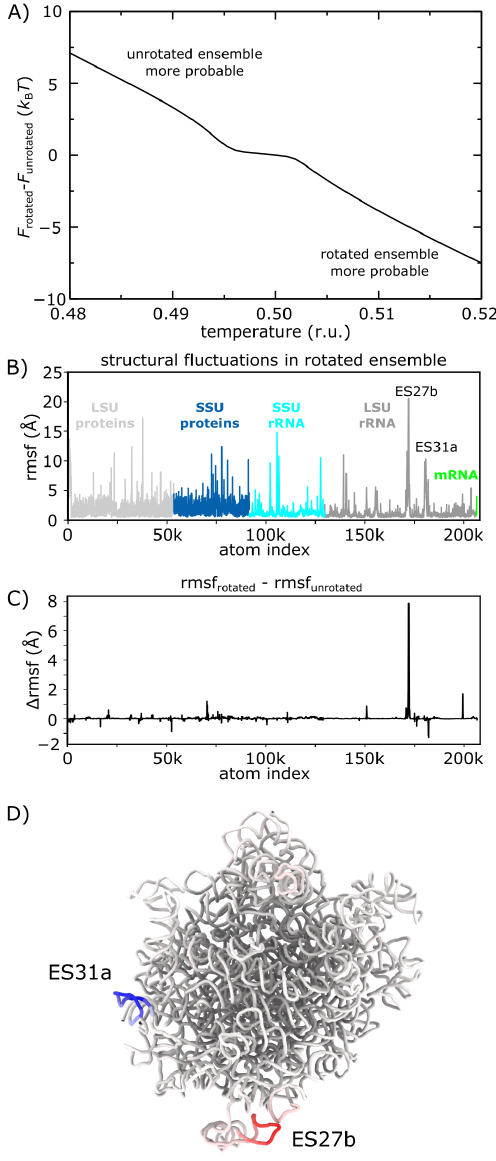
Figure 5. Temperature-dependent free-energy landscape. The presented simulations reveal how the free-energy landscape is influenced by changes in molecular flexibility upon rotation. ( A ) Difference in free energy of the rotated (5.40 ◦ < φ body < 7.83 ◦ ) and unrotated ( − 1.12 ◦ < φ body < 0.82 ◦ ) ensem- bles, as a function of temperature. Positive values indicate the free energy of the rotated ensemble is higher. As T is increased, the free energy of the rotated ensemble monotonically decreases, relative to the unrotated ensemble. ( B ) Spatial root mean squared fluctuations (rmsf), by atom, for all simulated frames within the rotated ensemble. Peaks in the protein regions are typically due to marginally ordered tails at the peripheral regions of the ribosome. ( C ) Difference between rmsf values calculated for the rotated and unrotated ensembles: ∆ rmsf. Positive values indicate elevated mobility in the rotated ensemble. Consistent with the temperature-induced shift in population towards the rotated ensemble (panel A), there is one region of the LSU rRNA that is significantly more flexible in the rotated ensemble (expansion segment 27b, ES27b). ( D ) Structural representation of the LSU rRNA, colored by ∆ rmsf values (blue to red). There is a large increase in flexibility of ES27b, suggesting that rotation allows this region to adopt a wider range of configurations and provide an entropic drive towards the rotated ensemble. This observation is consistent with the lack of electron density obtained for this region in a cryo-EM reconstruction of the rotated state